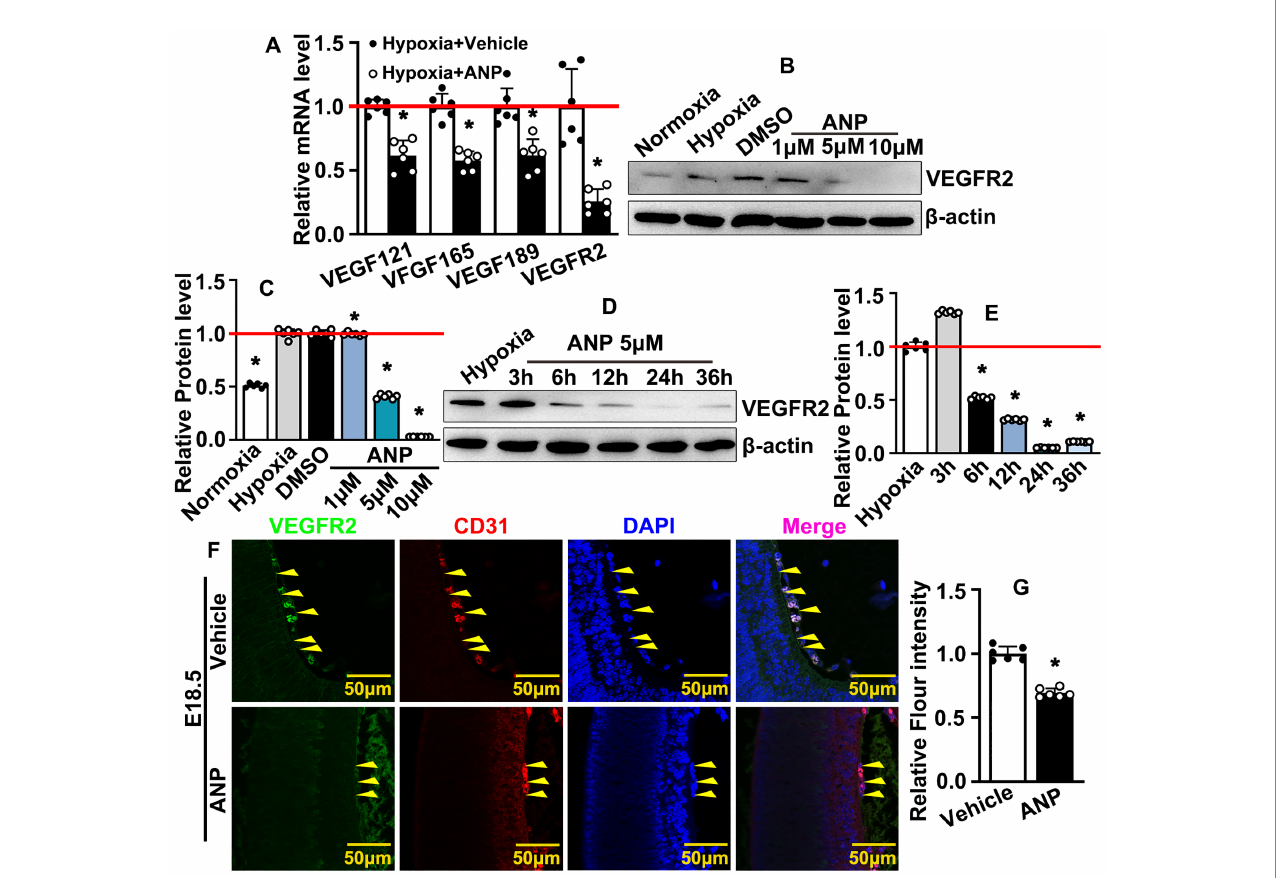
FIGURE 5 Andrographolide inhibits embryonic hyaloid vascular endothelial VEGFR2 expression during murine hyaloid vasculature development. (A) Hypoxia conditions were induced in HUVEC-C by 200 μ M CoCl 2 treatment following andrographolide treatment. Transcription levels of HIFs and VEGFR2 were evaluated by Real-time PCR ( n = 6). (B) Under hypoxia conditions, HUVEC-C was treated with different doses of andrographolide (1 μ M, 5 μ M and 10 μ M); VEGFR2 protein levels were determined by western blotting. (C) The quantification of VEGFR2 protein levels in (B) ( n = 6). (D) Hypoxia conditions were induced in HUVEC-C by 200 μ M CoCl 2 treatment, following 5 μ M andrographolide treatment. Total protein harvested at 3, 6, 12, 24, and 36 h, and western blotting was performed to determine VEGFR2 expression. (E) The quantification of relative VEGFR2 protein levels in (D) ( n = 6). (F) Immunofluorescence staining against VEGFR2 and CD31 antibodies was performed to evaluate hyaloid vascular endothelial VEGFR2 expression at E18.5 after andrographolide treatment. (G) The quantification of hyaloid vascular endothelial VEGFR2 expression at E18.5 after andrographolide treatment ( n = 6). Quantitative data presented as mean ± SEM, * p <